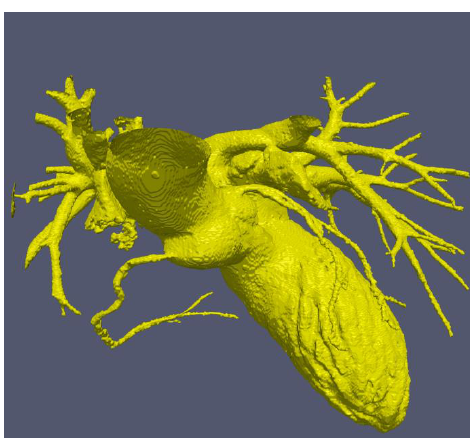
Fig. 7. CTA volume data segmentation.